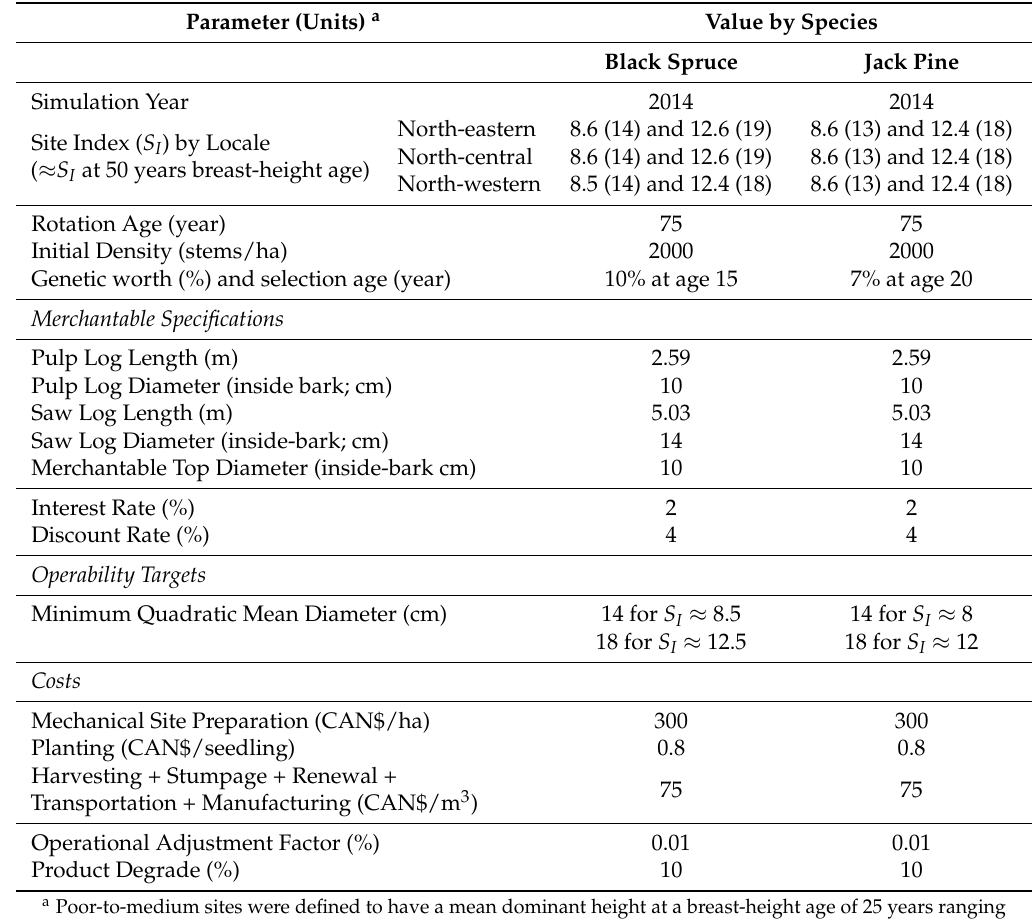
Table 2. Input variables and parameter settings used in the modified SSDMM